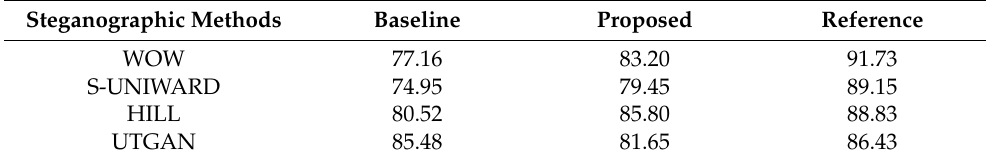
Table 1. Detection accuracy rates (%) of baseline, reference, and our scheme on four sequentially steganalysis tasks against the corresponding steganographic methods. Steganographic Methods